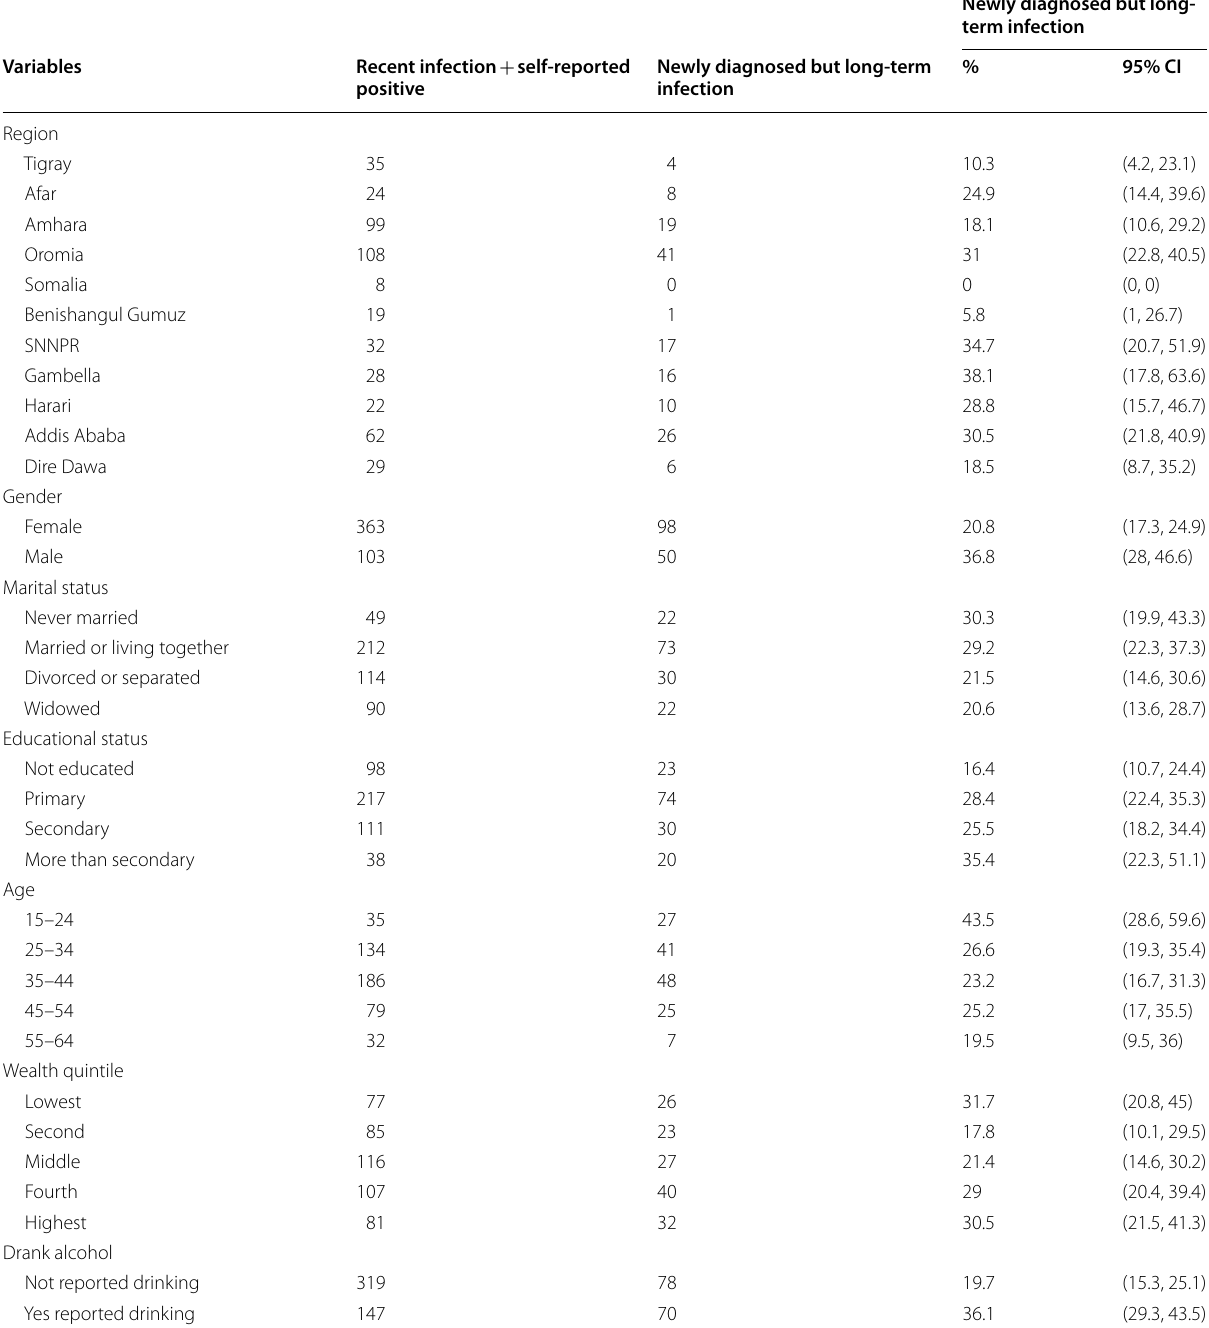
Table 3 Prevalence of late HIV diagnostics among people living with HIV (PLHIV) in urban-based population of Ethiopia